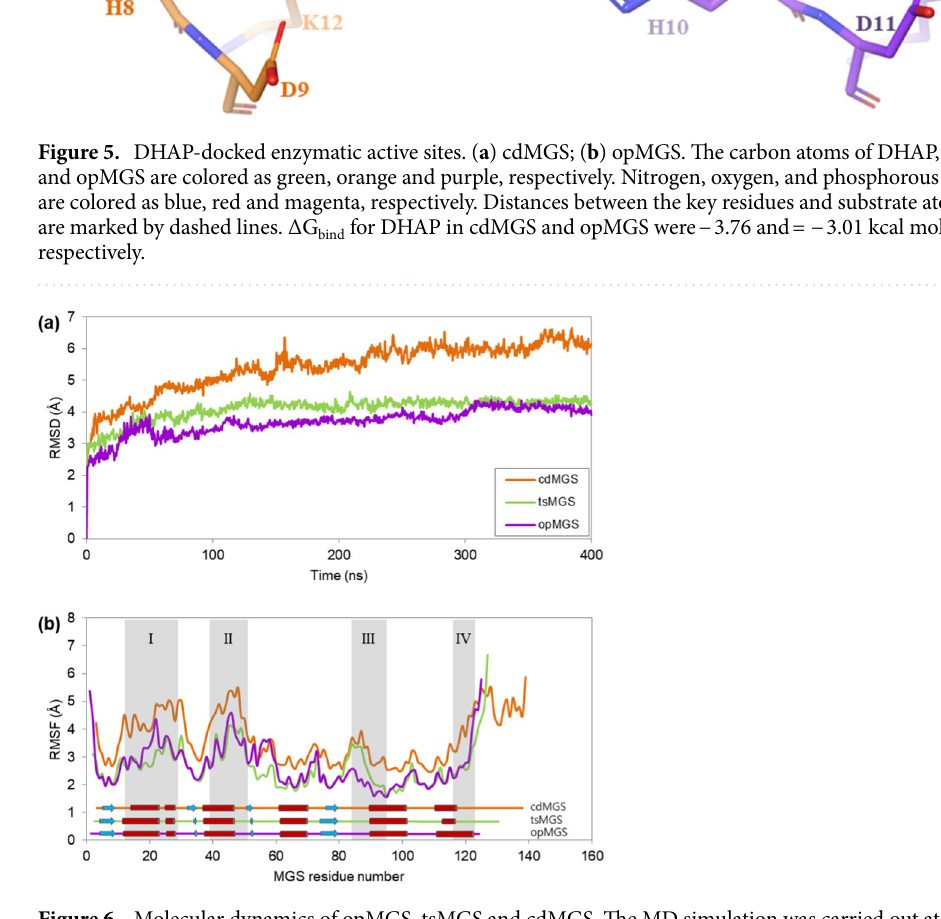
Figure 6. Molecular dynamics of opMGS, tsMGS and cdMGS. The MD simulation was carried out at 358 K for 400 ns. ( a ) Overall root-mean-square-deviation (RMSD) of the MGSs; ( b ) Root-mean-square-fluctuation (RMSF) for each residue of the MGSs. The three MGS sequences were aligned and a common set of residue numbers was assigned for the RMSF analysis of the homologous residues. Secondary structures such as α-helices (red cylinders), β-strands (blue arrows) and loops (lines with corresponding colors of the MGSs) are indicated. Regions of high difference in fluctuation between cdMGS and opMGS are shown as shaded boxes